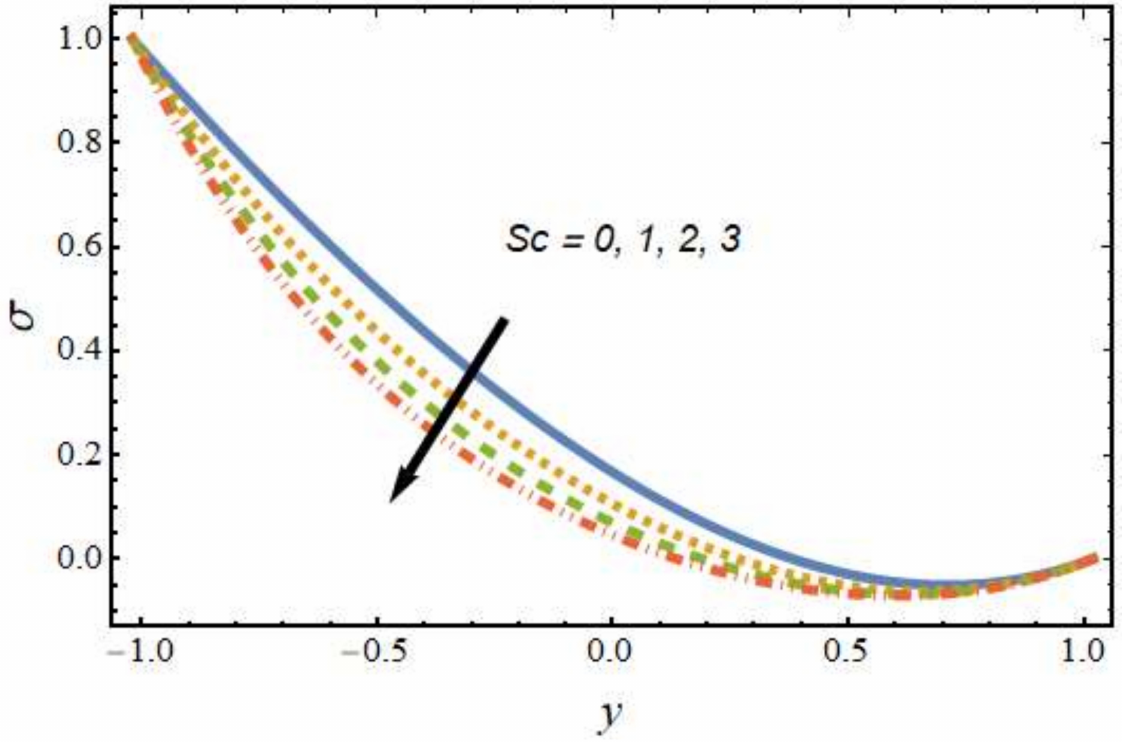
Figure 15. Nanoparticle concentration profile for various values of the Schmidt